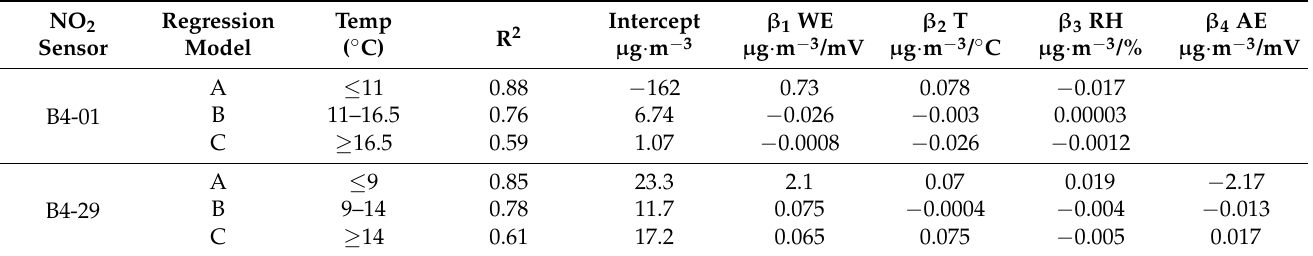
Figure 10. Time series of the 1-h average concentrations of NO 2 measured in the training campaign by the reference instrument and the sensors (calibrated response). Table 7. Regression coefficients of the MLR applied to different segments of data (temperature) generated by the NO 2